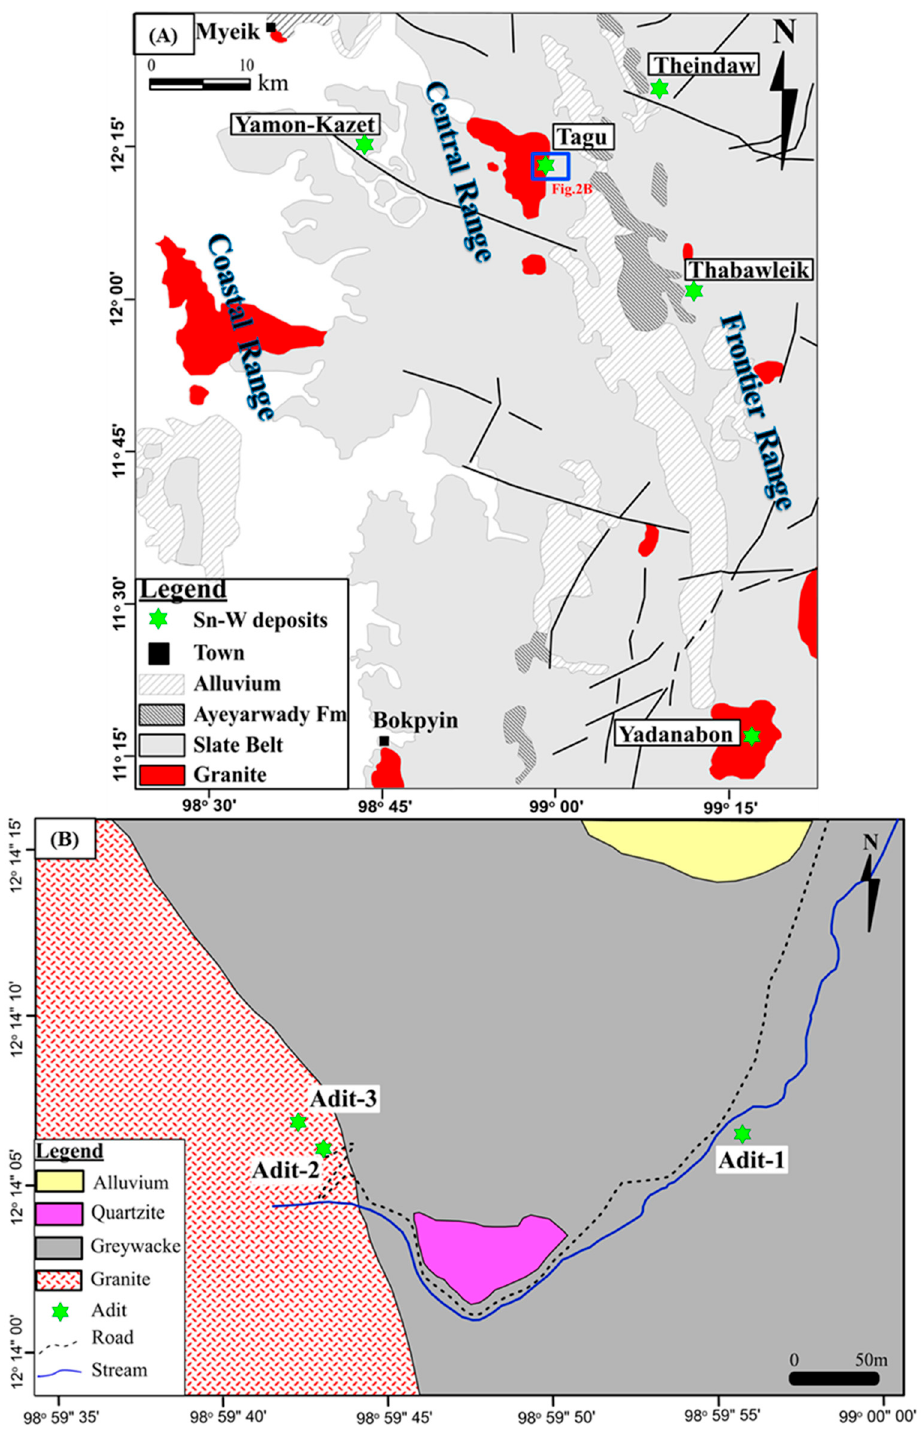
Figure 2. Geological setting of Myeik District, Southern Myanmar. ( A ). Regional geology of Mergui District [25]. ( B ). Geological map of the Tagu mine area.